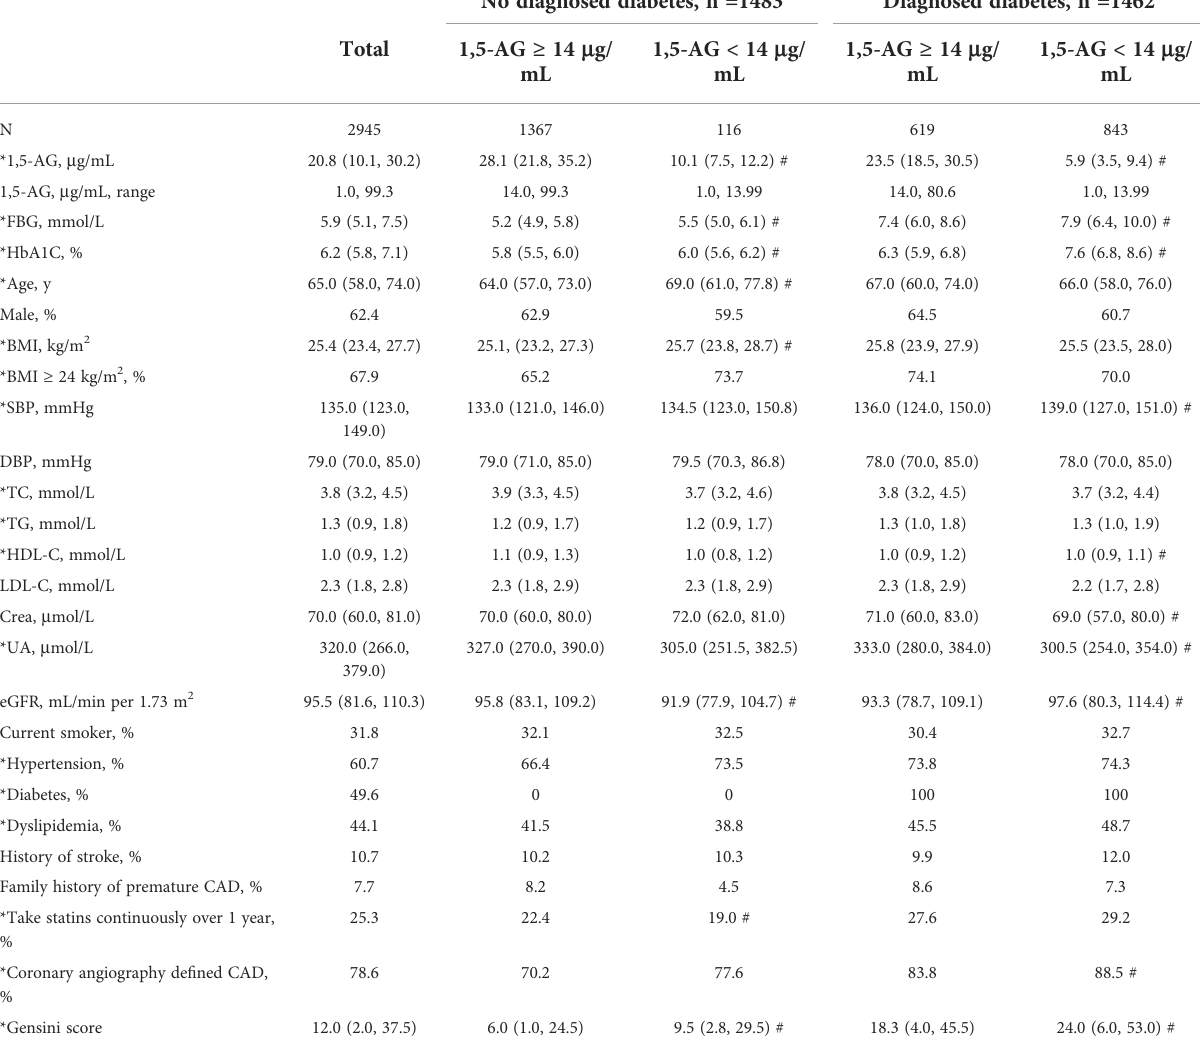
TABLE 1 Characteristics of the study participants by categories of 1,5-anhydroglucitol (1,5-AG) at baseline in subjects with and without diagnosed diabetes. No diagnosed diabetes, n